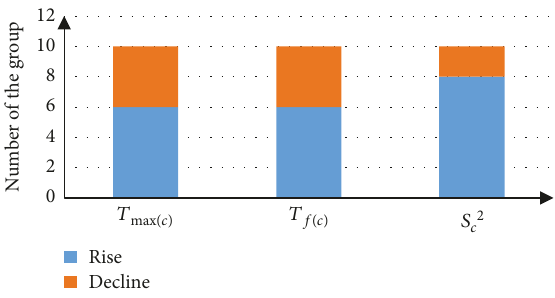
Figure 6: Feature parameters ’ variation in the warping phase.